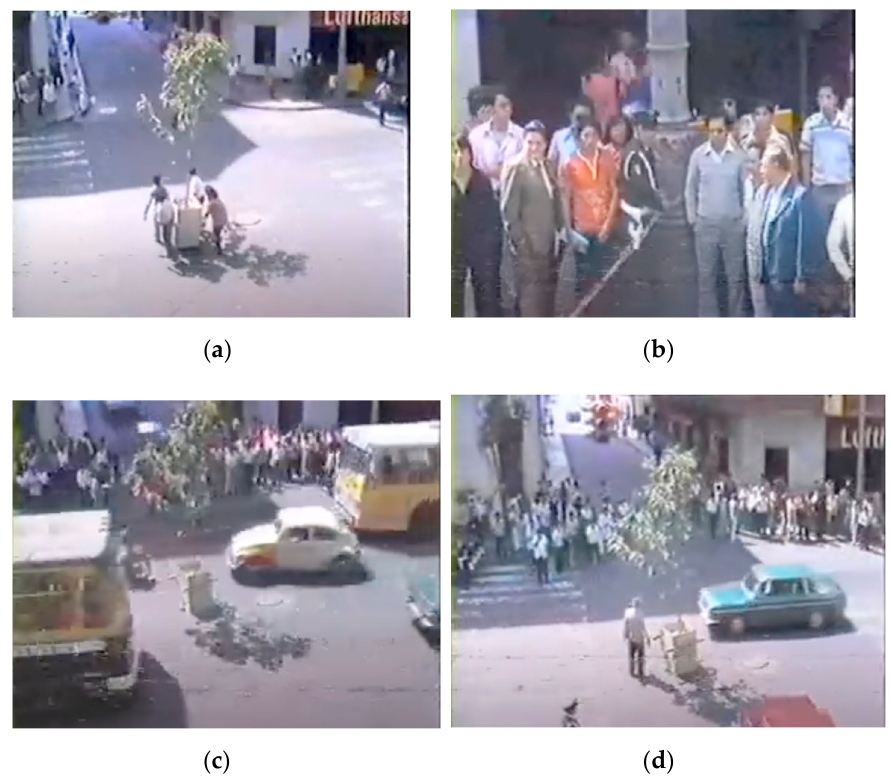
Figure 1. ( a – d ) Rossana Agois, Wiley Ludeña, Hugo Salazar del Alcázar, and Armando Williams, Lima en un árbol , 1981. Screenshots depict the placement of the tree ( a ), a police officer attempting to untie the rope ( b ), the resumption of traffic ( c ), and a pedestrian pausing to look at the tree ( d ). Published with permission of the artists.